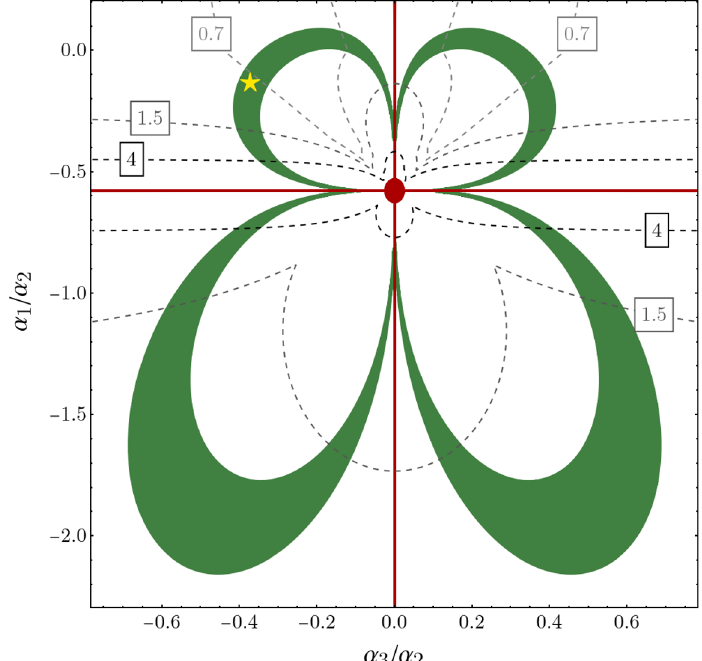
model with large Im τ which, 4